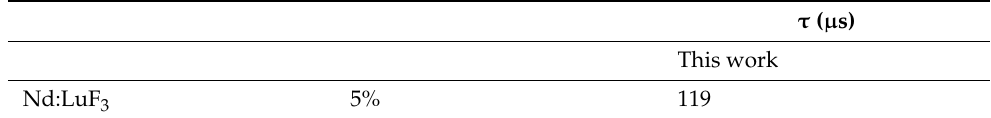
Table 11. Decay time of Nd:LuF 3